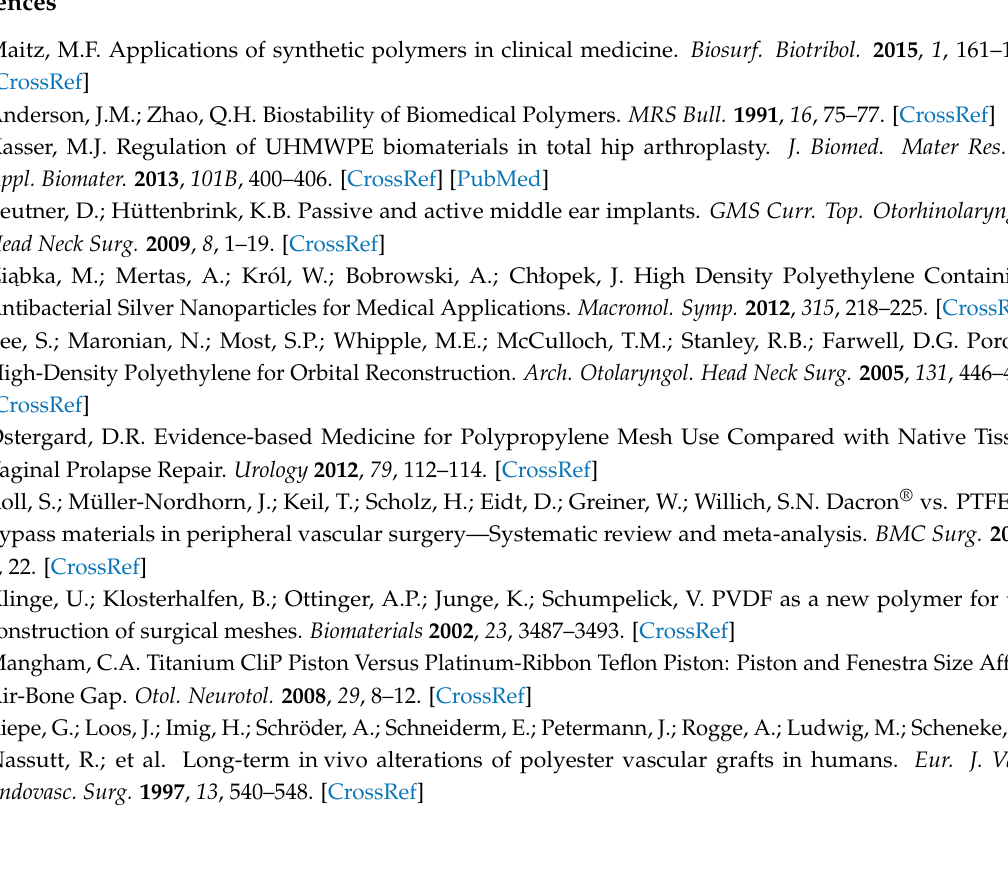
Figure S1: SEM images of surface and cross-section of the 203FC-based materials before and after 12-month incubation in deionized water; Figure S2: SEM images of surface and cross-section of the SG7-based materials before and 12-month incubation in deionized water; Figure S3: Tensile stress-strain curve of the 205FC- ( A ), 203FC- (B), SG10- ( C ), and SG7-based ( D ) materials before and after 6-month and 12-month incubation in deionized